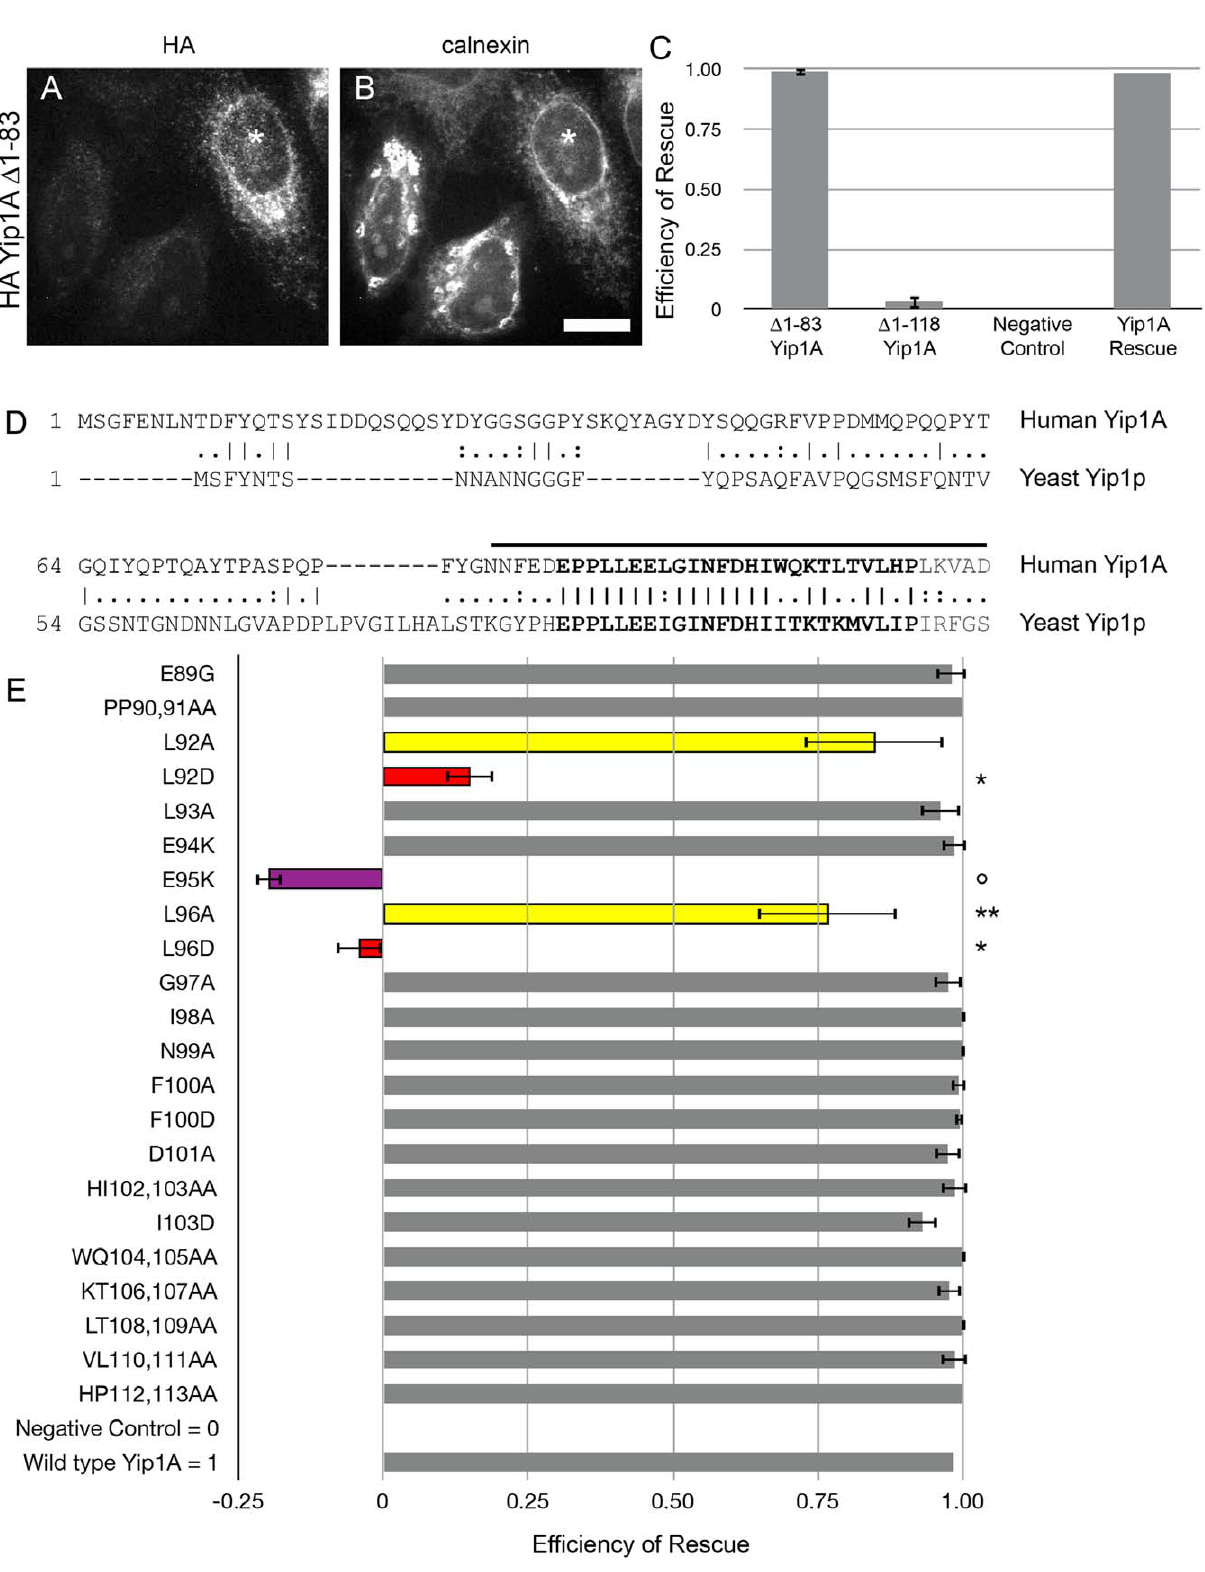
Figure 2. Only a few highly conserved residues in the Yip1A cytoplasmic domain are required for function. Cells co-transfected with Yip1A siRNA and HA-Yip1A D 1-83 were fixed after 72 h and co-stained with antibodies against HA (A) and calnexin (B). The asterisk (A and B) marks an expressing cell that did not exhibit ER whorls. Scale bar, 10 m m. (C) Quantification of the efficiency of rescue by HA-Yip1A D 1–83, HA-Yip1A D 1–118 and the negative control Myc-Sec61 b . Data were from 3 independent experiments ( . 100 cells per experiment), 6 SD. (D) An alignment of the cytoplasmic domains of human Yip1A with yeast Yip1p. Residues 83–118 are bracketed, with the highly conserved block highlighted in bold. (E)